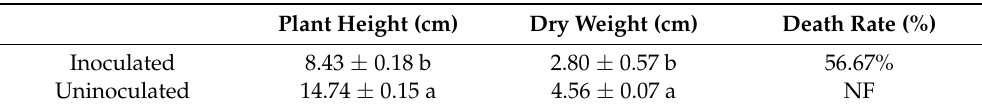
Table 2. Effect of F. proliferatum on M. hupenhensis Rehd. seedlings. Inoculated: 100 mL conidia sus- pensions (10 4 spores/mL) inoculated for 4 weeks; Uninoculated: 100 mL sterile water as control. Data are the means of thirty replicates ( ± SE), different letters indicate significant differences at p < 0.05. Plant Height (cm) Dry Weight (cm) Death Rate (%) Inoculated Uninoculated